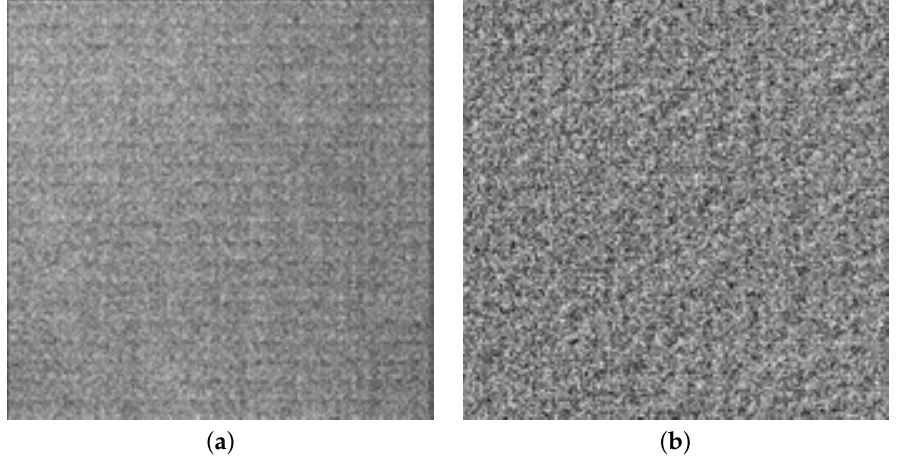
Figure 2. FPN of the IMX265LLR-C at 60 ◦ C and 12 dB of analog gain: ( a ) no zoom and ( b ) 8 ×